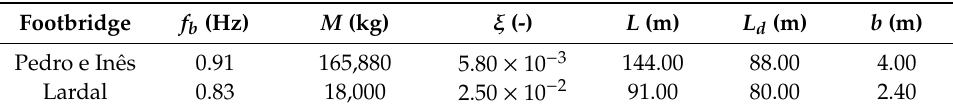
Table 3 . Numerical response simulation. Results obtained by applying the proposed method. Table 2. Numerical response simulation. Data